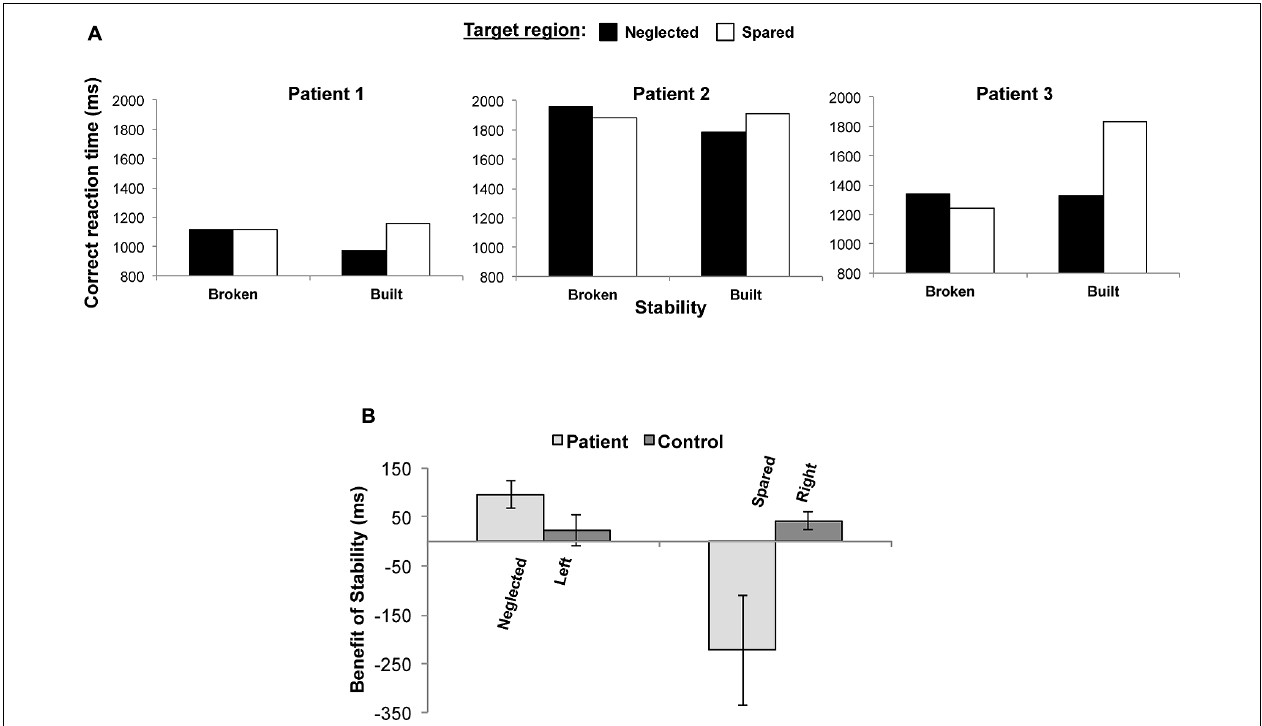
was the benefit of stability different in patients’ neglected regions and controls’ left hemifields, but there was a significant detriment when the background remained stable and the target was presented in patients’ spared regions compared to when it was presented in the right hemifield for control participants (Error bars represent ± 1 standard error of the mean).